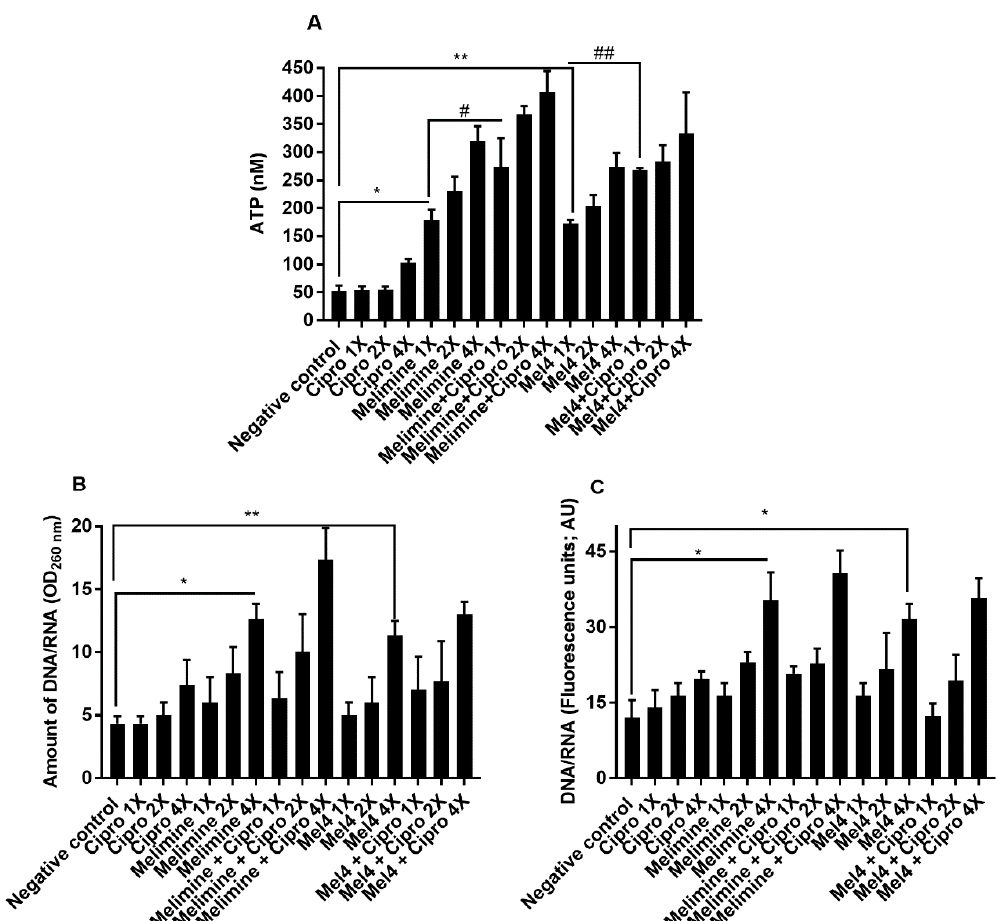
Figure 7. Leakage of ( A ) ATP and ( B , C ) nucleic acid from pre-formed biofilm cells of P. aeruginosa ATCC 27853. Leakage of ATP or nucleic acid from pre-formed (24 h) biofilms of P. aeruginosa ATCC 27853 following treatment for 3 h with either of the two peptides and ciprofloxacin alone or in combination. The strain was made resistant to ciprofloxacin by passage for 30 days at a sub-MIC concentration (0.25 µg/mL). * represent significant ( p = 0.001) and ** represent significant ( p = 0.002) increases in the amount of ATP or nucleic acid release compared to the negative control. # represent significant ( p = 0.044) increase in the release of ATP of the combination of melimine and ciprofloxacin compared to melimine alone, and ## represent a significant ( p = 0.039) increase in the release of ATP of the combination of Mel4 and ciprofloxacin compared to Mel4 alone.